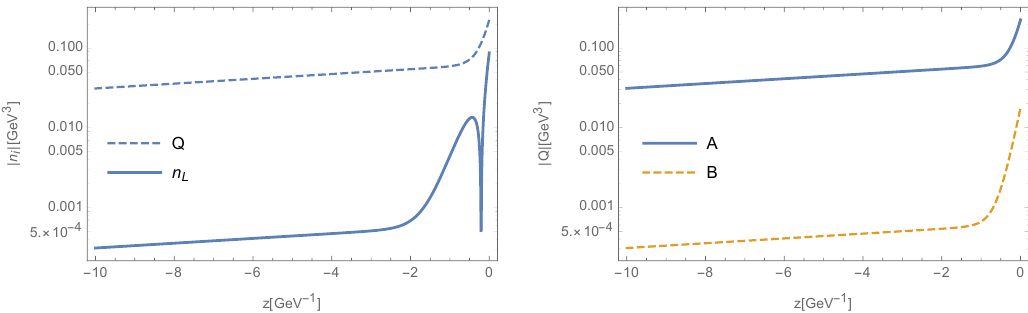
Figure 5 . Left panel: absolute value of the number density Q (dashed blue) and n L (solid blue) in the symmetric phase for scenario A . The suppression of n L is especially e(cid:14)cient for z < (cid:0) 2. Right panel: absolute value of the number density Q in the symmetric phase for scenario A (solid blue) and scenario B (dashed yellow). The density in scenario A is not only larger at the bubble wall at z = 0, but it has also di(cid:11)used into the symmetric phase more e(cid:11)ectively. The number densities T and H show similar